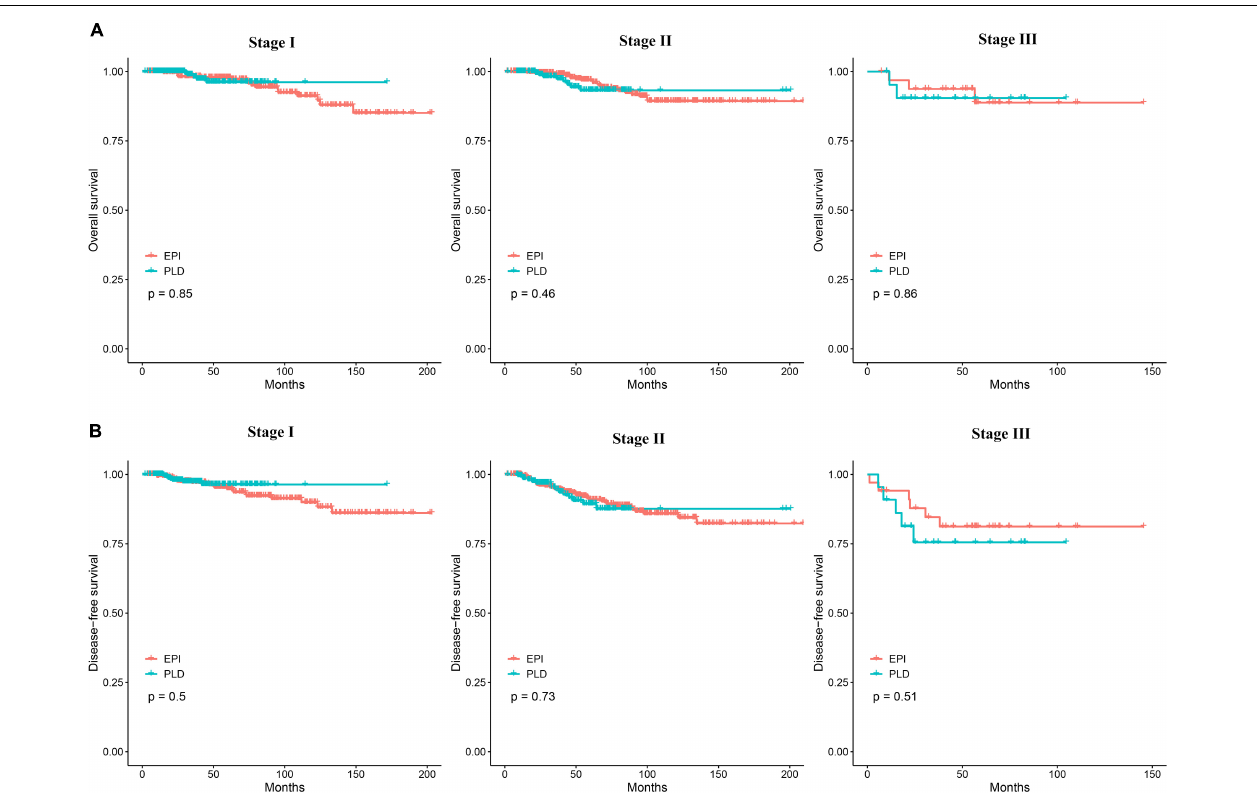
FIGURE 2 | (A) The Kaplan–Meier curves comparing OS between the two groups for stage I, II, and III breast cancer. (B) The Kaplan–Meier curves comparing DFS between the two groups for stage I, II, and III breast cancer. OS, overall survival; DFS, disease-free survival.